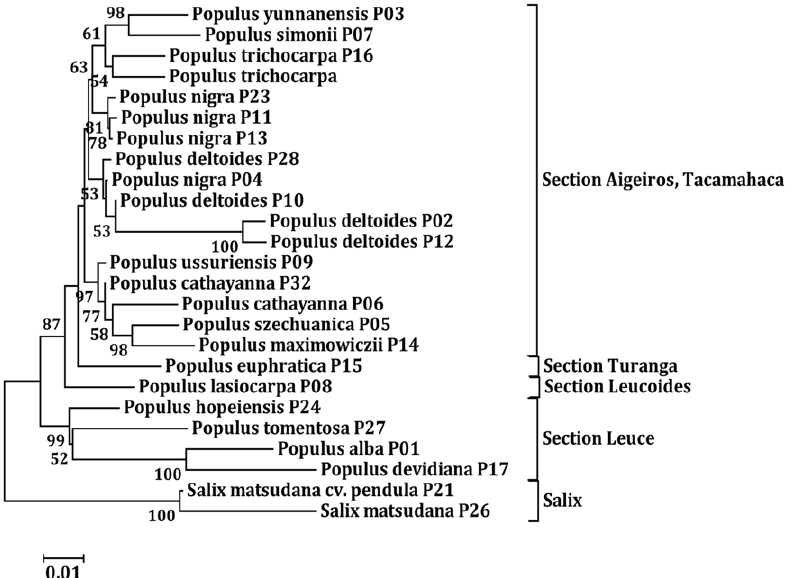
Figure 5. Neighbor-joining phylogenetic trees based on the MIR482-MIR1448 polycistron and rDNA-ITS combined dataset in Populus . Numbers in the tree represent the bootstrap value (bootstrap values below 50% are not shown at the nodes). Two Salix clones were treated as an outgroup.